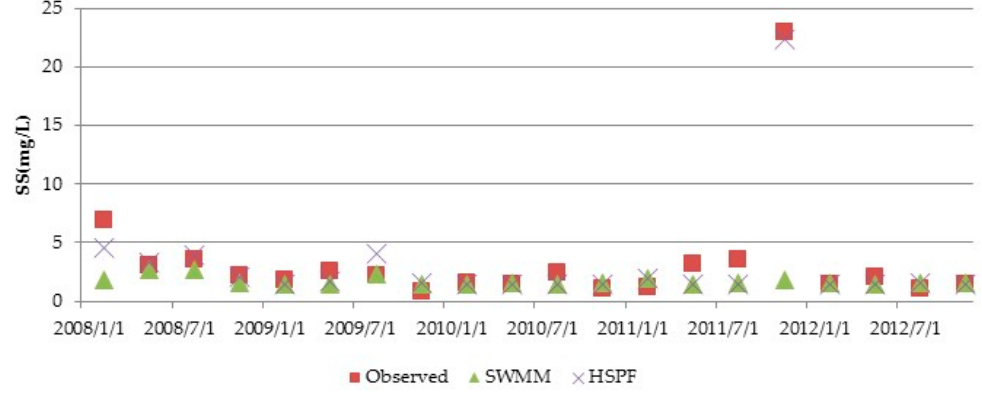
Figure 6. Validation of the SS simulation for the HSPF model and SWMM.